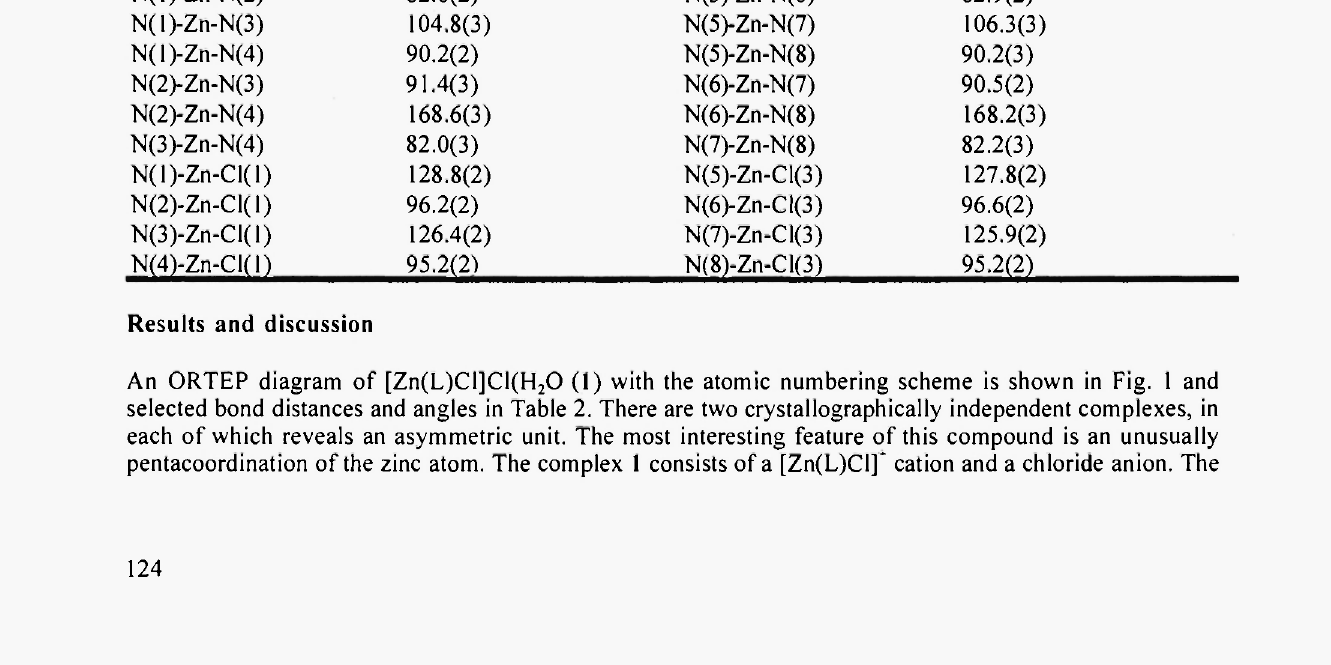
Table 2. Selected Bond Distances (Ä) and Angles (°) for